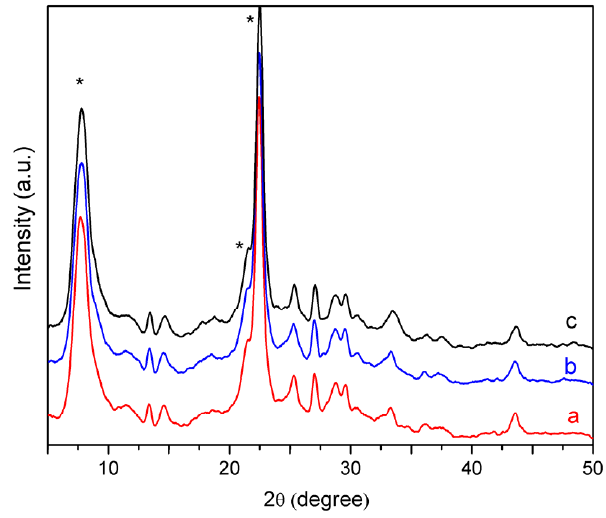
Figure 4. XRD patterns for Beta zeolite (a), 0.5Pd@Beta (b), and 1Pd@Beta (c) samples.